Question: According to the figure, is the described quantity increasing or decreasing?
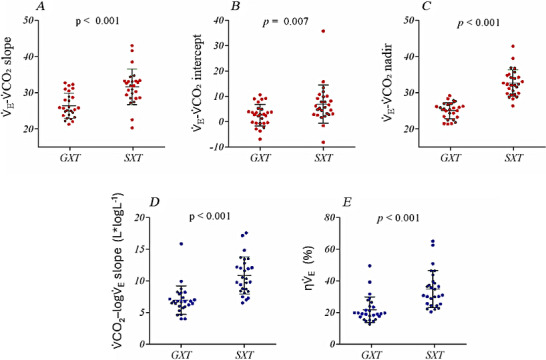
Answer: increasing